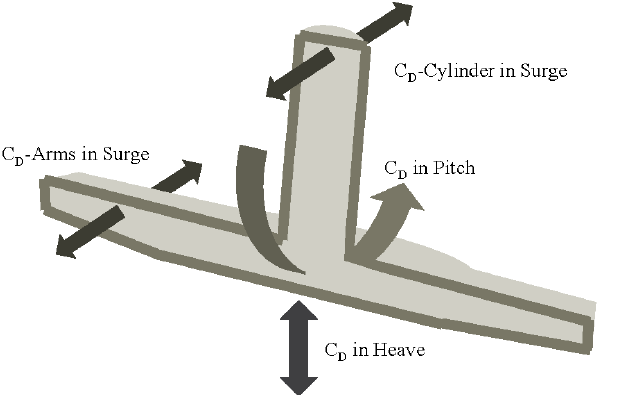
Figure 4. Definition of the directions of drag coefficient application with respect to the structural